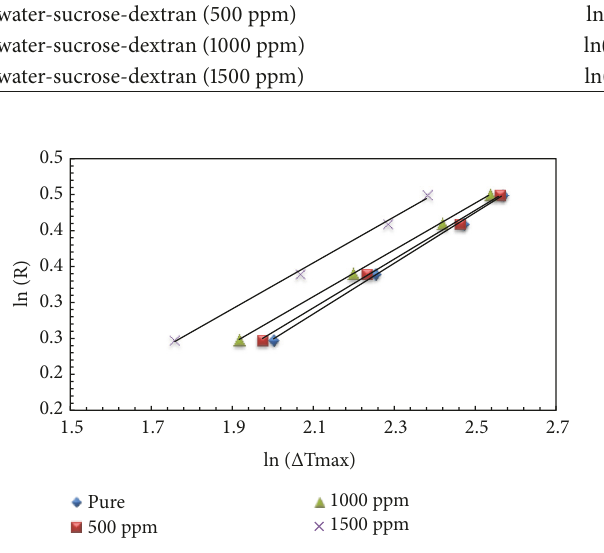
) for sucrose aqueous solutions Figure 3: Plot ln ( R ) versus ln (Δ T max without and with dextran.